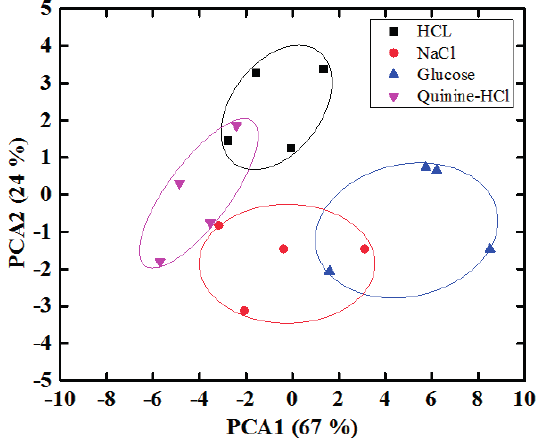
Figure 14. Result of PCA applied to the dataset from the proposed IDC taste sensor array of mixed taste